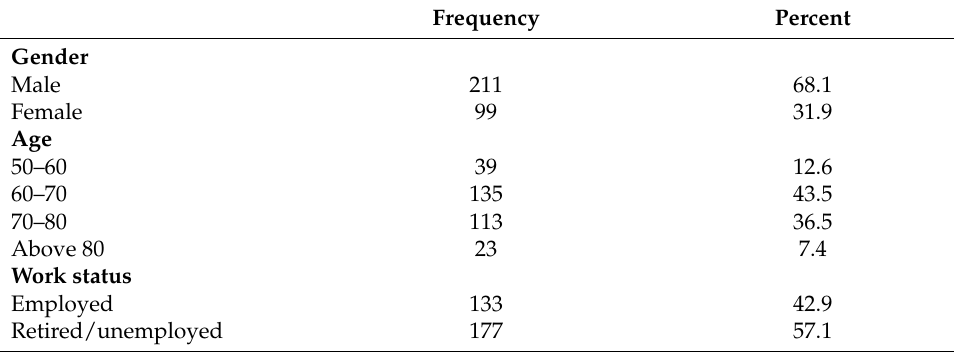
Table 1. Demographic assessment (N =